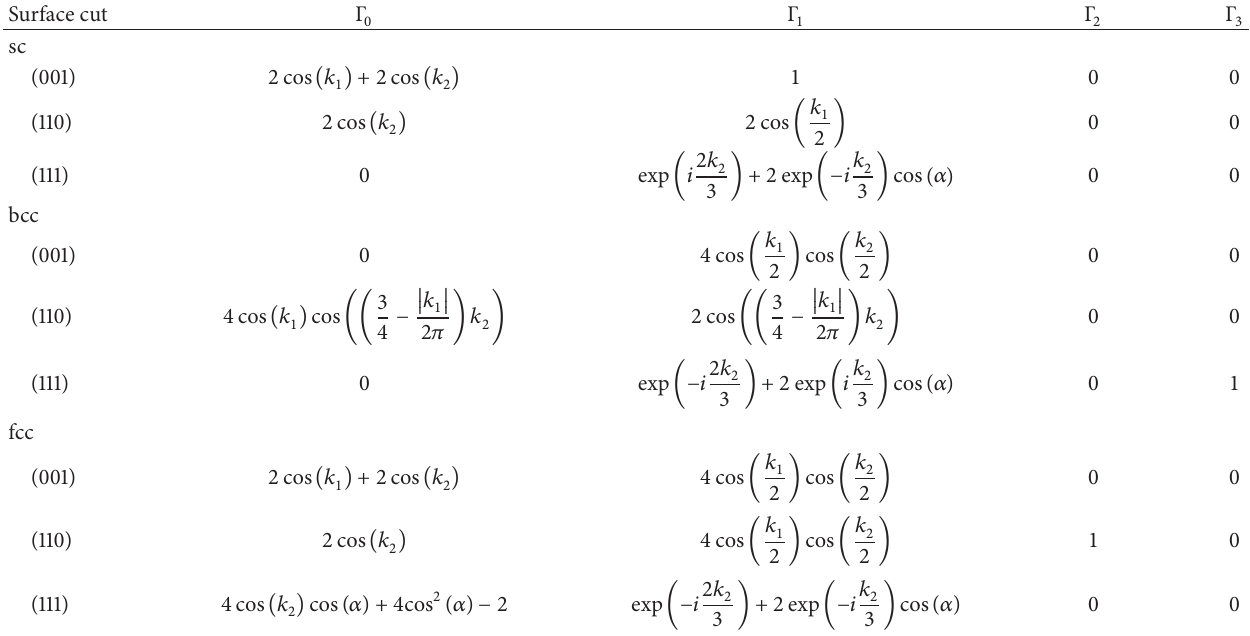
Table 2: Structural sums Γ 𝑛 for nearest neighbors disposed in adjacent lattice planes 𝑙 ± 𝑛 , 𝑛 = 0, ...,3 , parallel to the surface in thin films considered in the paper.